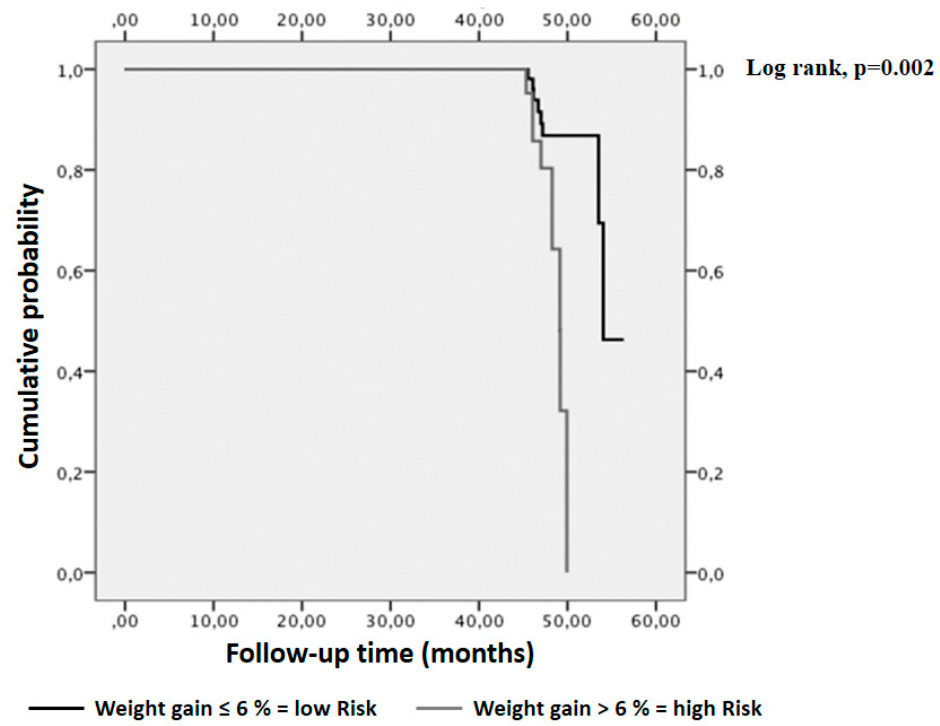
Figure 1. Impact of weight change on liver steatosis worsening in patients with IBD. Kaplan–Meier analyses demonstrated that a significantly higher liver steatosis deterioration event rate was observed with increasing body weight more than 6% (log–rank test, p = 0.002).